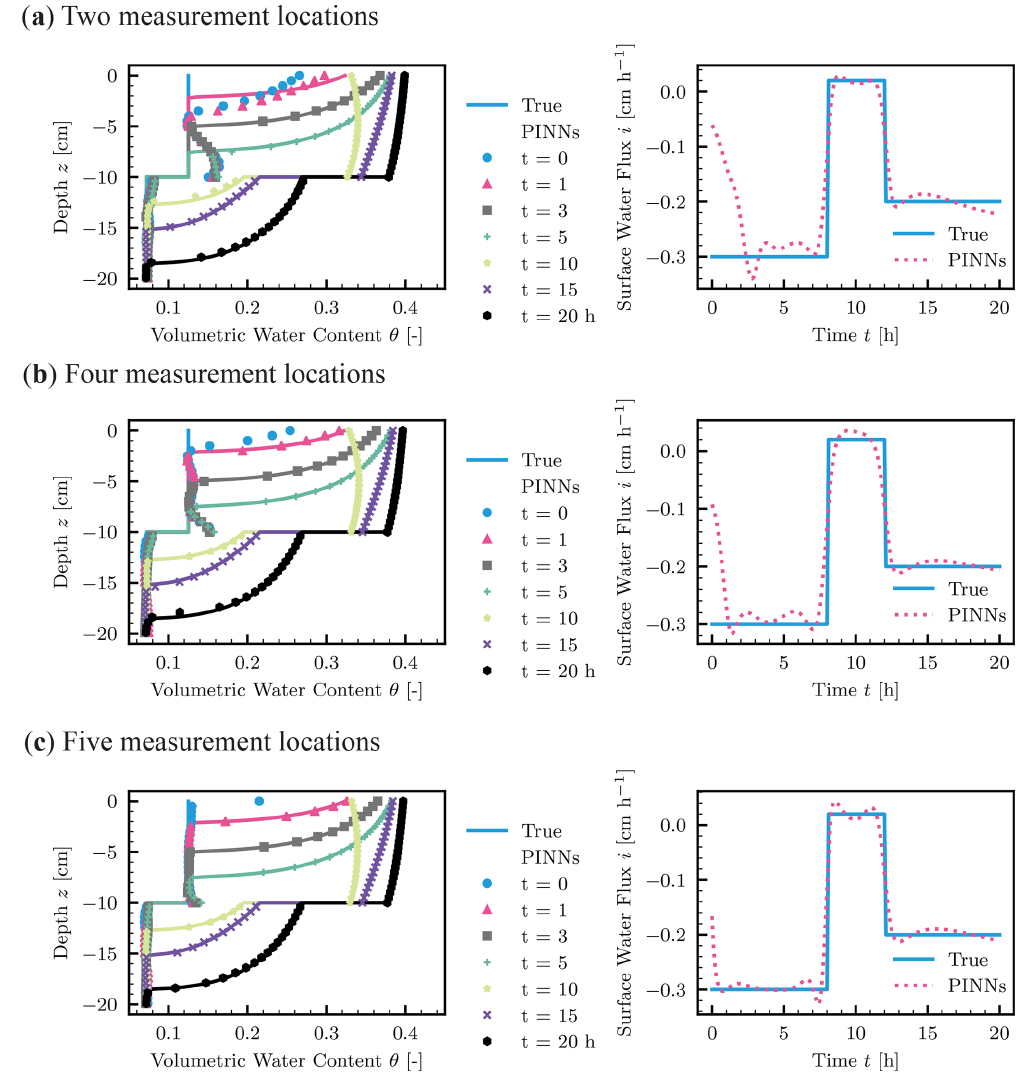
Figure 16. Inverse modeling to estimate surface water flux from soil moisture measurements in a layered soil (upper layer– loam soil and lower layer – sandy loam soil). True solution generated by HYDRUS-1D and the recovered solution by PINNs (left column) and the true and estimated upper surface water flux boundary condition (right column) for different measurement locations z m [cm]. (a) z m ∈ {− 5 , − 15 } . (b) z m ∈ {− 3 , − 7 , − 13 , − 17 } . (c) z m ∈ {− 1 , − 5 , − 9 , − 13 , − 17 }